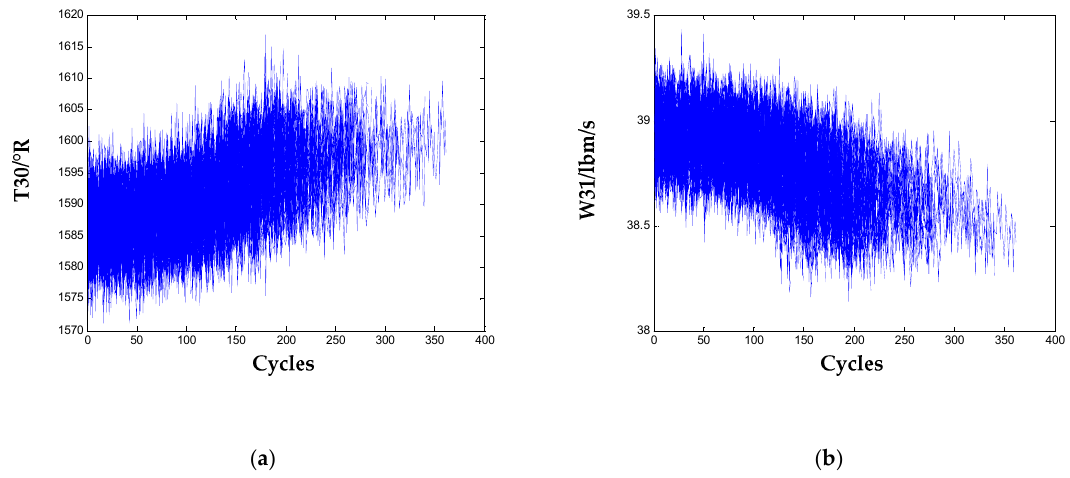
Figure 4. Sensor signals for the 100 training engines: ( a ) T30; ( b ) W31.